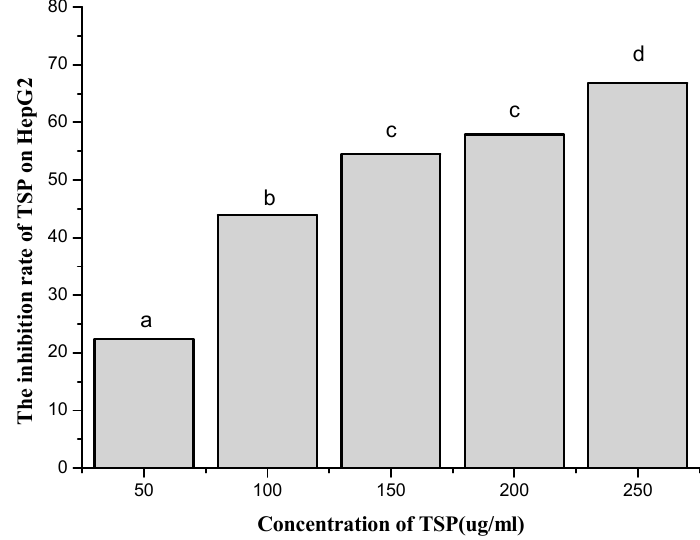
Figure 3. The effect of different concentrations of TSP on the inhibition rate of HepG2 by MTT assay (a, b, c, d denote significant difference at p < 0.05).